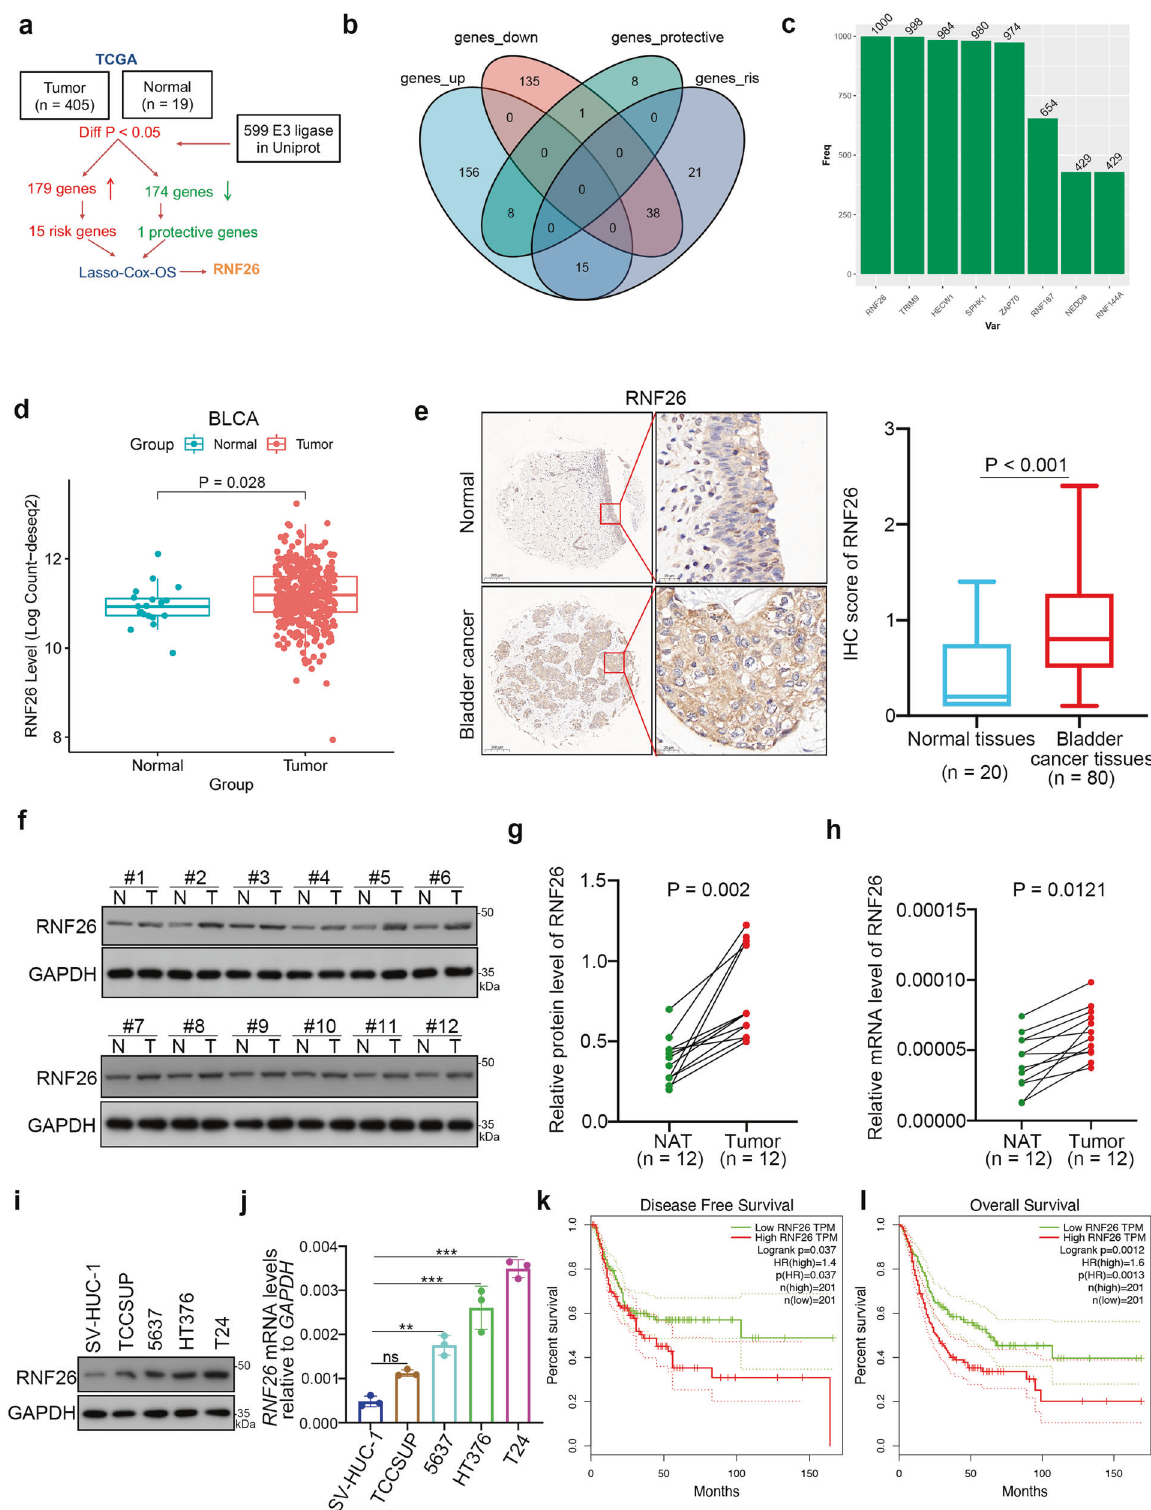
Short hairpin RNA (shRNA) infection and reagents shRNAs were obtained from GeneCopoeia (HSH111798-LVRU6GP, USA), and the sequences of the shRNAs are provided in Table S1. Cells were transfected with the indicated plasmids or shRNAs using Lipofectamine